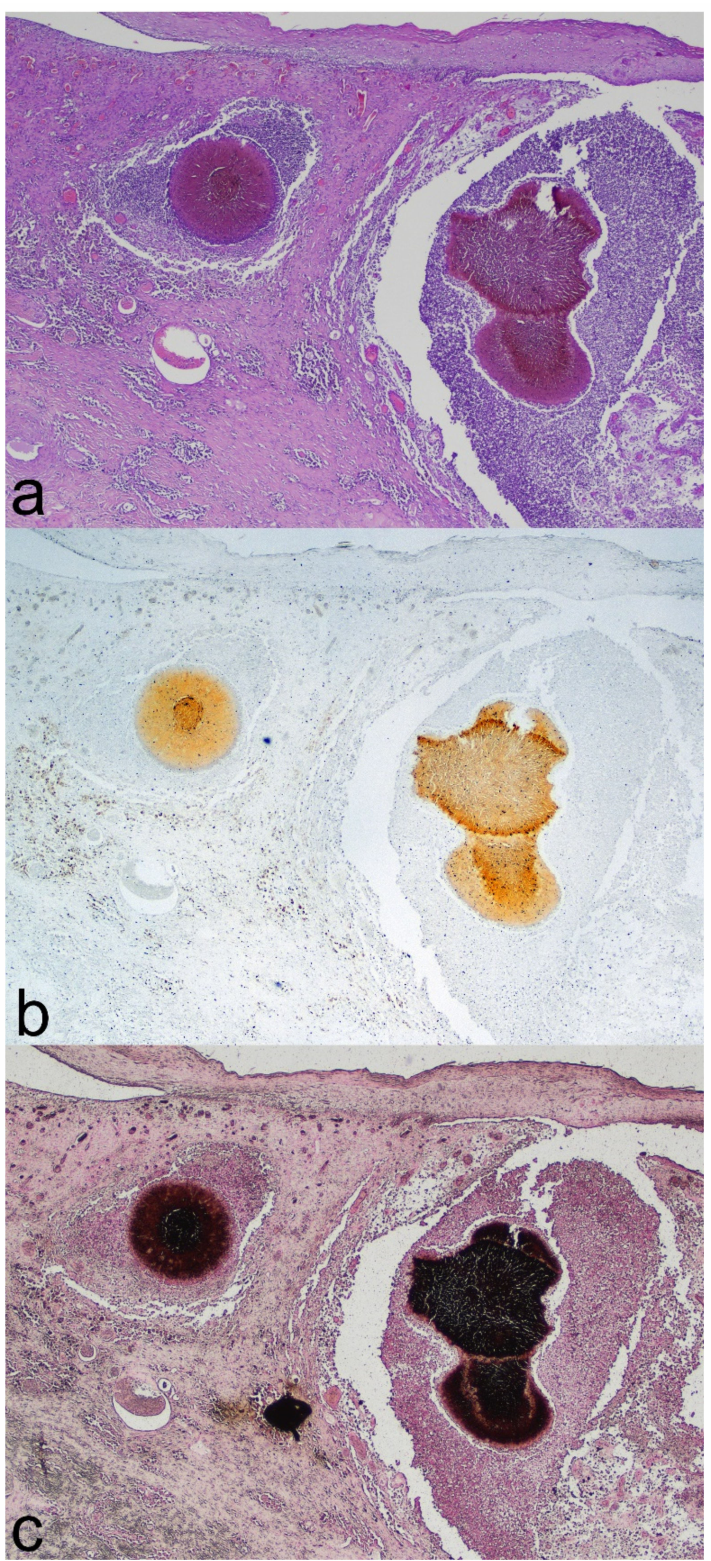
Figure 1. Skin histopathology. ( a ) In the superficial dermis, two individual nodules composed of pyogranulomatous reactions centered on dark-pink fungal aggregates (HE stain). ( b ) Serial unstained section demonstrating the light-brownish pigmentation of the fungal aggregates. ( c ) Serial section stained with Fontana–Masson stain showing highly melanized fungal